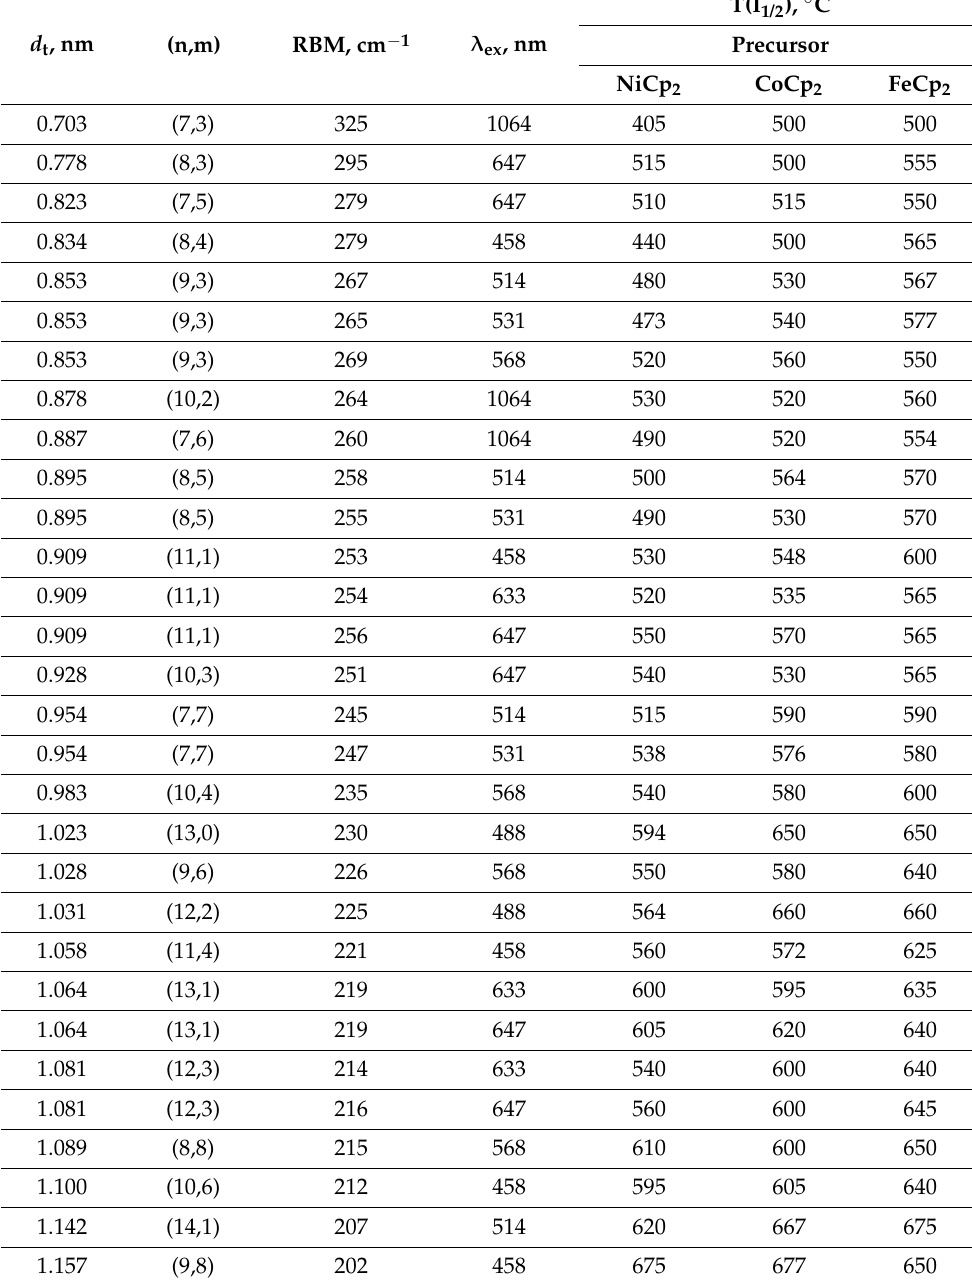
Table 1. The diameters ( d t ), chiral indexes (n, m), RBM peak positions, excitation laser wavelengths ( λ ex ) and evaluated T(I 1/2 ) growth temperatures of the inner tubes observed in the Raman spectra of the annealed NiCp 2 -, CoCp 2 - and FeCp 2 -filled